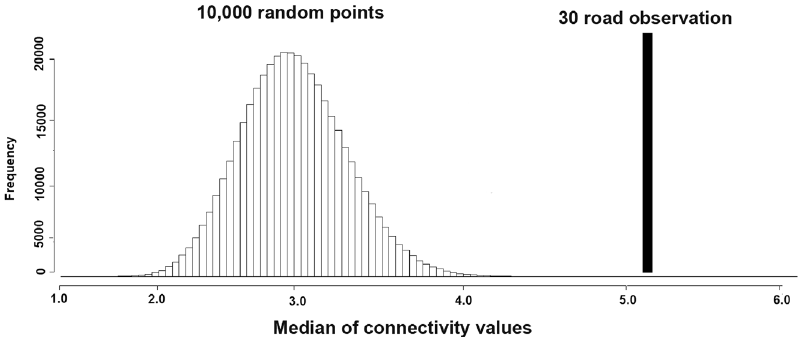
Figure 6. Spatial randomization test: 30 road observations (18 crossing + 12 collisions) of the striped hyaena and 10,000 random points along the dangerous roads of the study